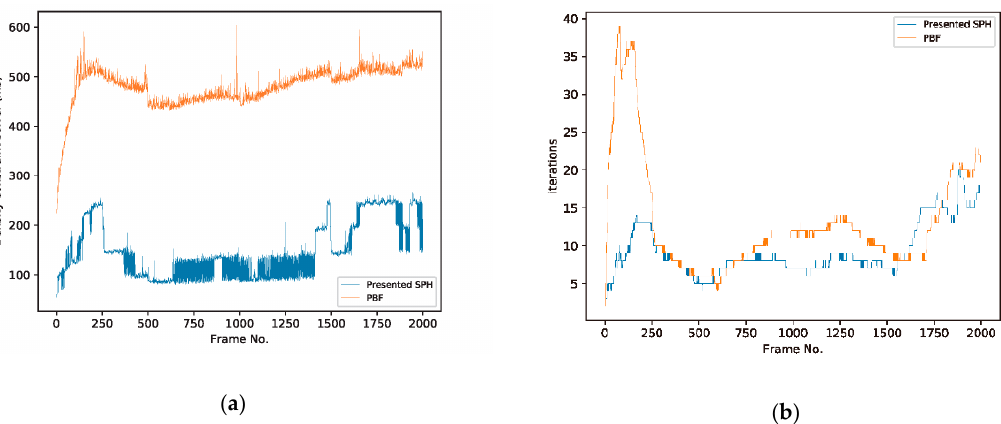
Figure 3. ( a ) The comparison of density constraint solver solution time in the first 2000 images of PBF model (orange curve) and our SPH model (blue curve). The solution speed of our SPH model is obviously improved. ( b ) The number of iterations required to reduce the average density change ρ err to the threshold 0.01 g / m 3 during the iteration of the density constraint solver. The orange and blue curves represent the number of iterations of PBF method and our method, respectively.